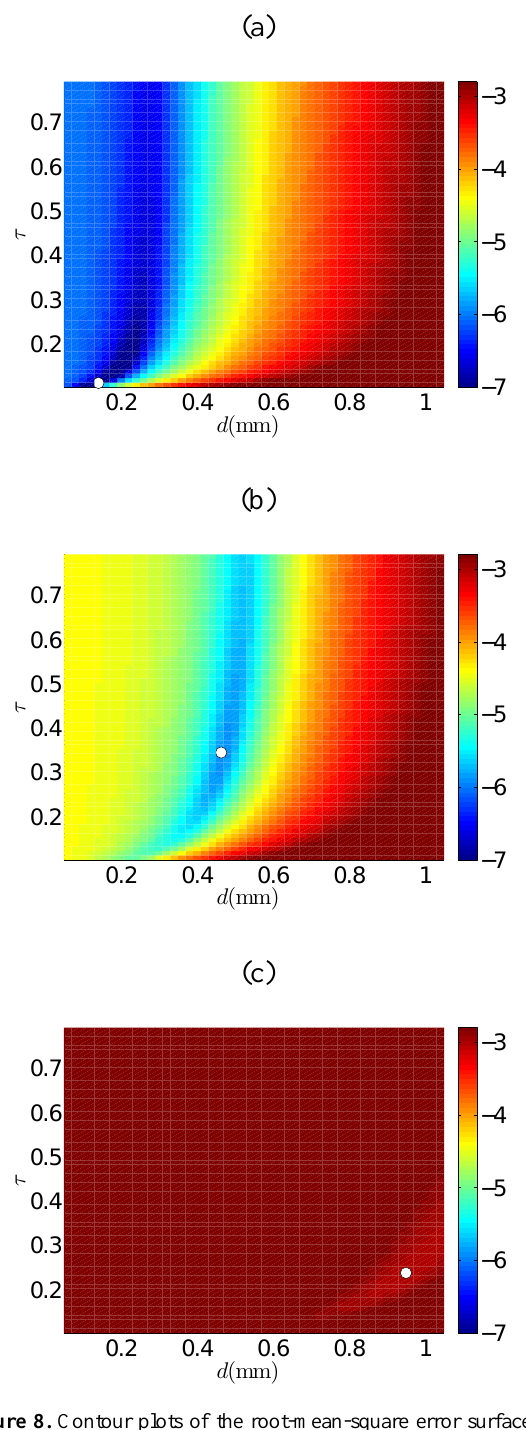
Figure 8. Contour plots of the root-mean-square error surface for different snow types. Colors show the logarithm of the sum of the squared differences between measured and parametric SHS form e C(k) (cf. Eq. 39) as a function of ( τ , d ) for different examples. (a) Precipitation particles (PP). (b) Large rounded grains (RG). (c) Depth hoar (DH). The optimal values ( ˆ d , ˆ τ ) for the respective sample are shown as white circles.